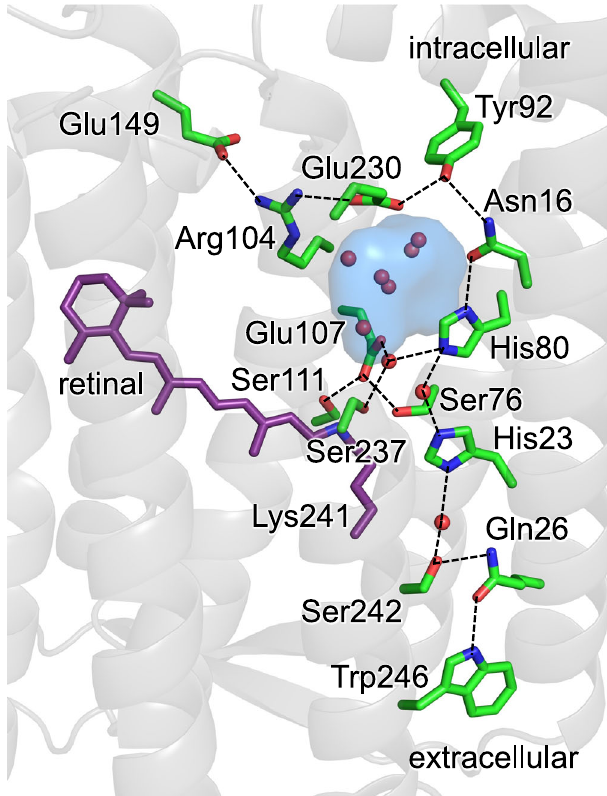
Fig. 1 H-bond network that proceeds from the Schiff base via Glu107 in heliorhodopsin 48C12. Dotted lines indicate H-bonds. The cavity fi lled with a cluster of water molecules is shown as a blue